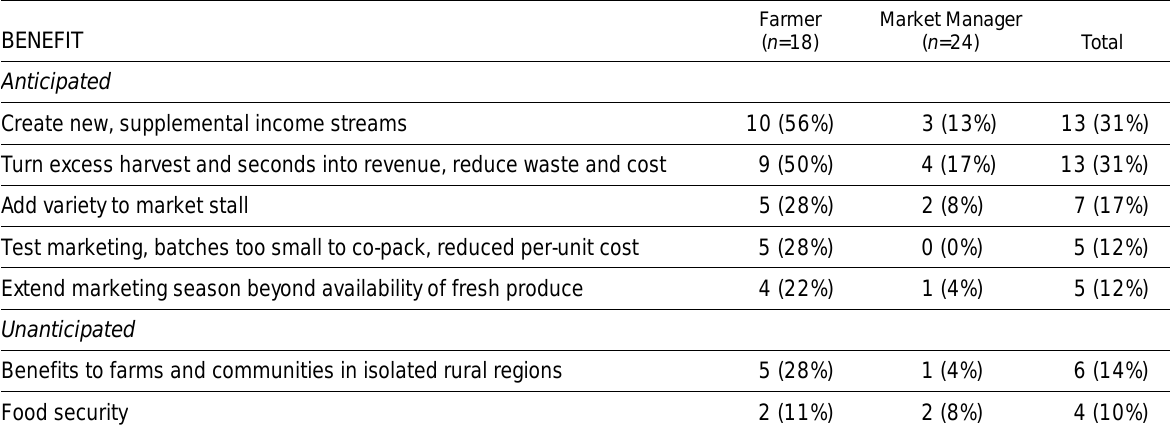
Table 3. Benefits Related to Using the Farm Direct Marketing Law (FDML) ( N =42)